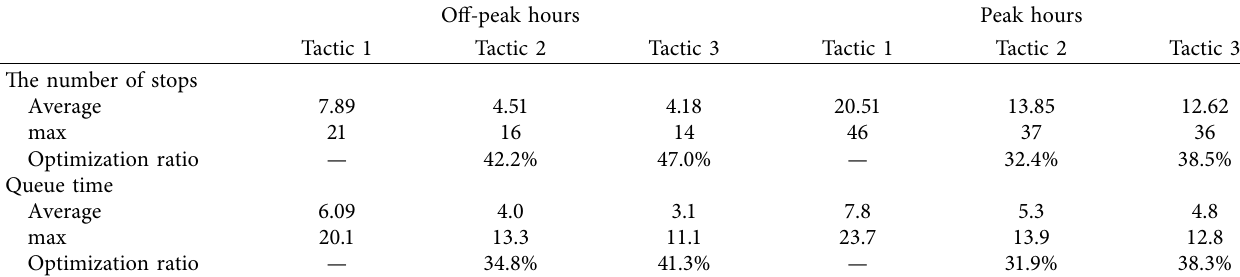
Table 2: Comparison of evaluation indicators with diferent control